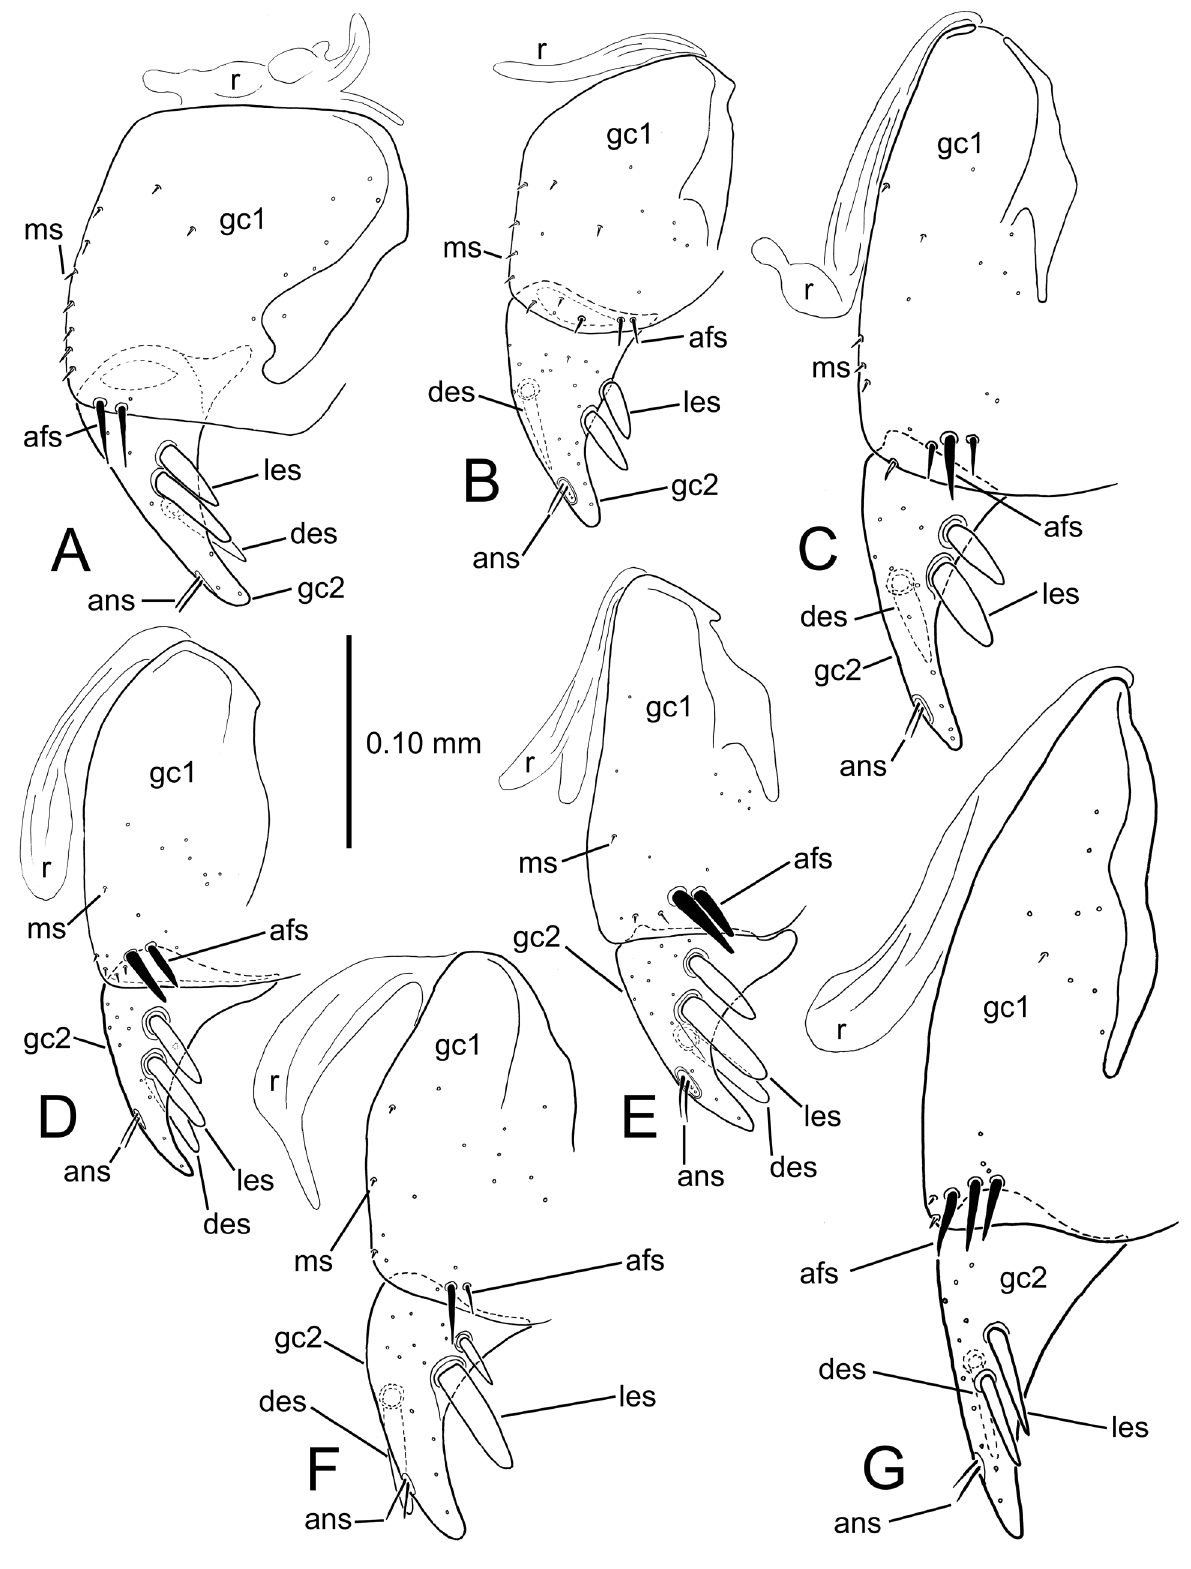
Figure 13. Left female gonocoxa, ventral view, Mecyclothorax ( Phacothorax ) spp.: A , M. laterobustus ; B , M. laterosinuatus ; C , M. laterorectus ; D , M. fleutiauxi ; E , M. jeanneli ; F , M. plurisetosus ; G , M. megalovatulus . See Table 2 for